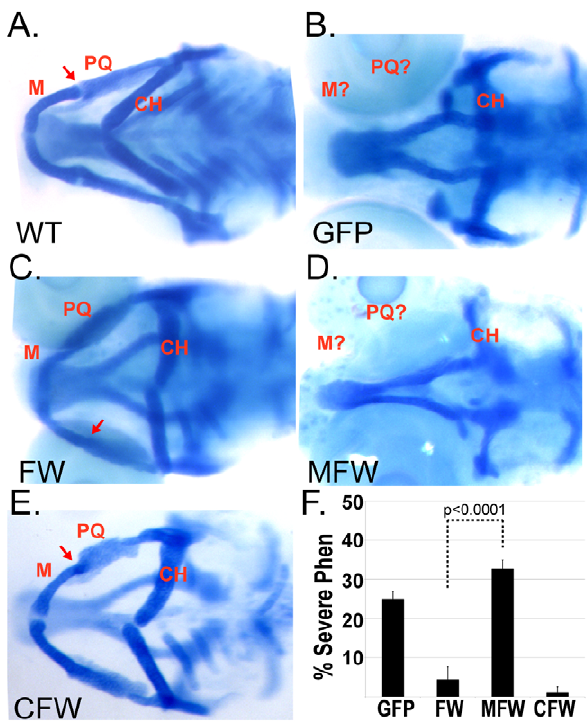
Figure 3. Fusion of Wdr68 to the Mad repression domain is not tolerated in vivo. A–E) Ventral views of alcian blue stained animals with the Meckel’s (M), palatoquadrate (PQ) and ceratohyal (CH) labeled in red. A) Wildtype sibling. Red arrow indicates the M-PQ jaw joint. B) Severe craniofacial defects in wdr68 hi3812 animals and failure of GFP mRNA to rescue. C) Rescue of the severe craniofacial defects by injection of FlagWdr68 (FW) mRNA. Red arrow indicates the mild M-PQ joint fusion phenotype. D) Severe craniofacial defects in wdr68 hi3812 animals and failure of MadFlagWdr68 (MFW) mRNA to rescue. 52/52 mutants genotyped were wdr68 hi3812 homozygotes. E) Rescue of the severe craniofacial defects by injection of CebpFlagWdr68 (CFW) mRNA. Red arrow indicates the mild M-PQ joint fusion phenotype. F) Graph summarizing the results of four injection trials. In aggregate, n=112/ 452 (25%) for GFP animals, n=16/352 (4.5%) for FW animals, n=96/296 (32%) for MFW animals, and n=2/149 (1.3%) for CFW animals.